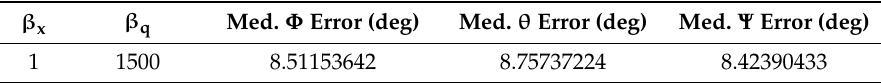
Table 8. Euler angle errors of the weighted Euclidean-based model (30,000 iterations).